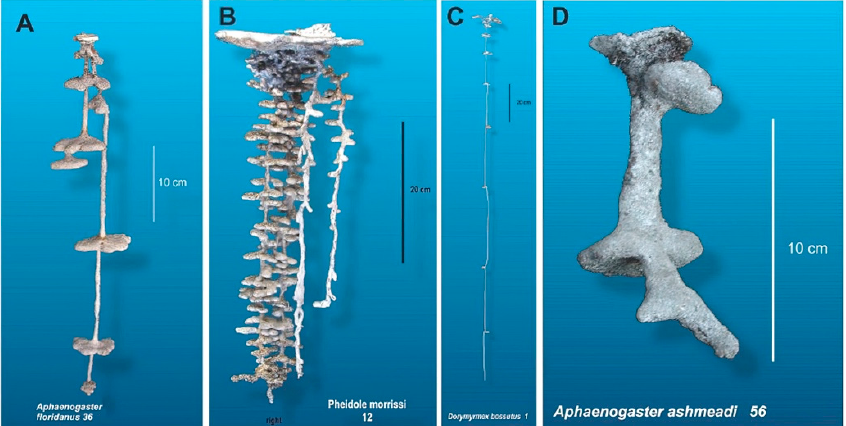
Figure 2. Examples of casts made of different materials. ( A ) Aphaenogaster floridana, dental plaster; ( B ) Pheidole morrisi, aluminium; ( C ) Dorymyrmex bossutus, zinc; ( D ) Aphaenogaster ashmeadi, paraffin wax.